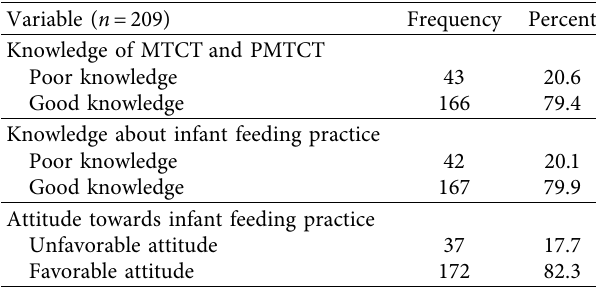
Table 2: Mother’s knowledge on MTCT and PMTCT of